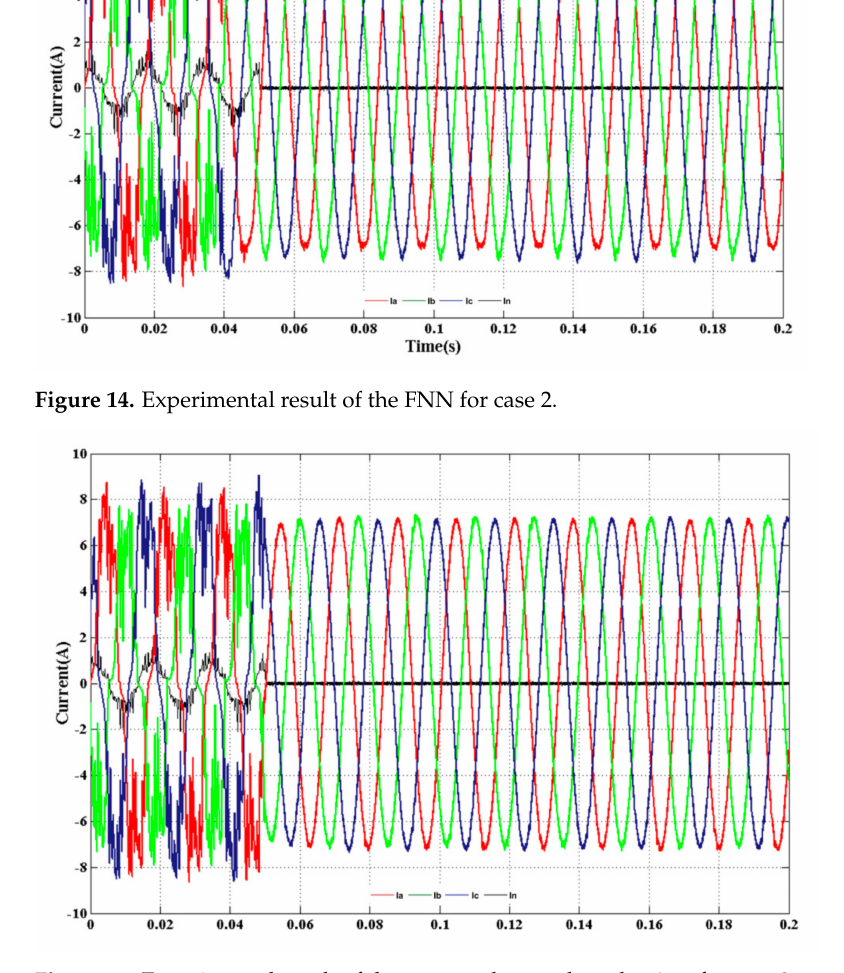
Figure 15. Experimental result of the proposed control mechanism for case 2. Table 3. Experimental results for case